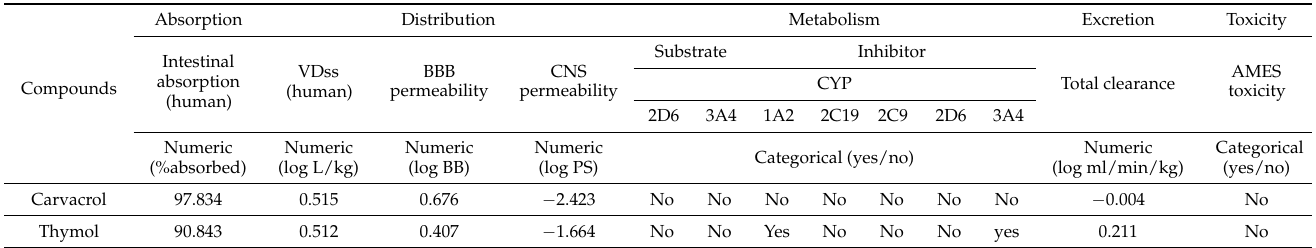
Table 8. ADMET in silico prediction of thymol and